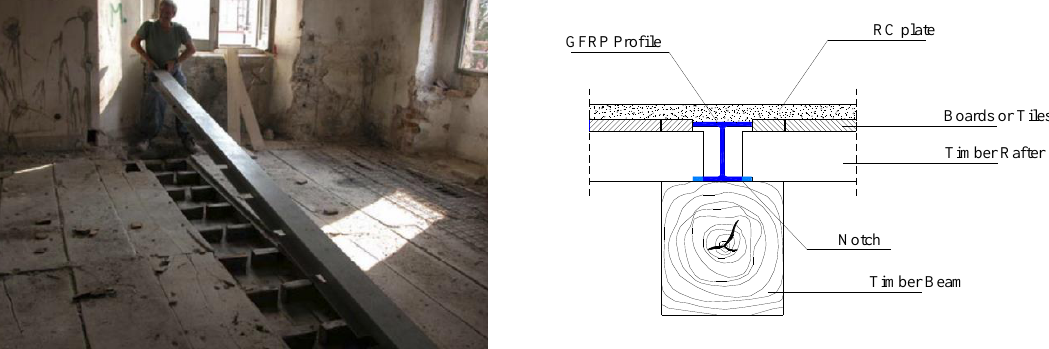
Figure 2. The use of GFRP I- or H-type beams applied at the compression side of timber beams.